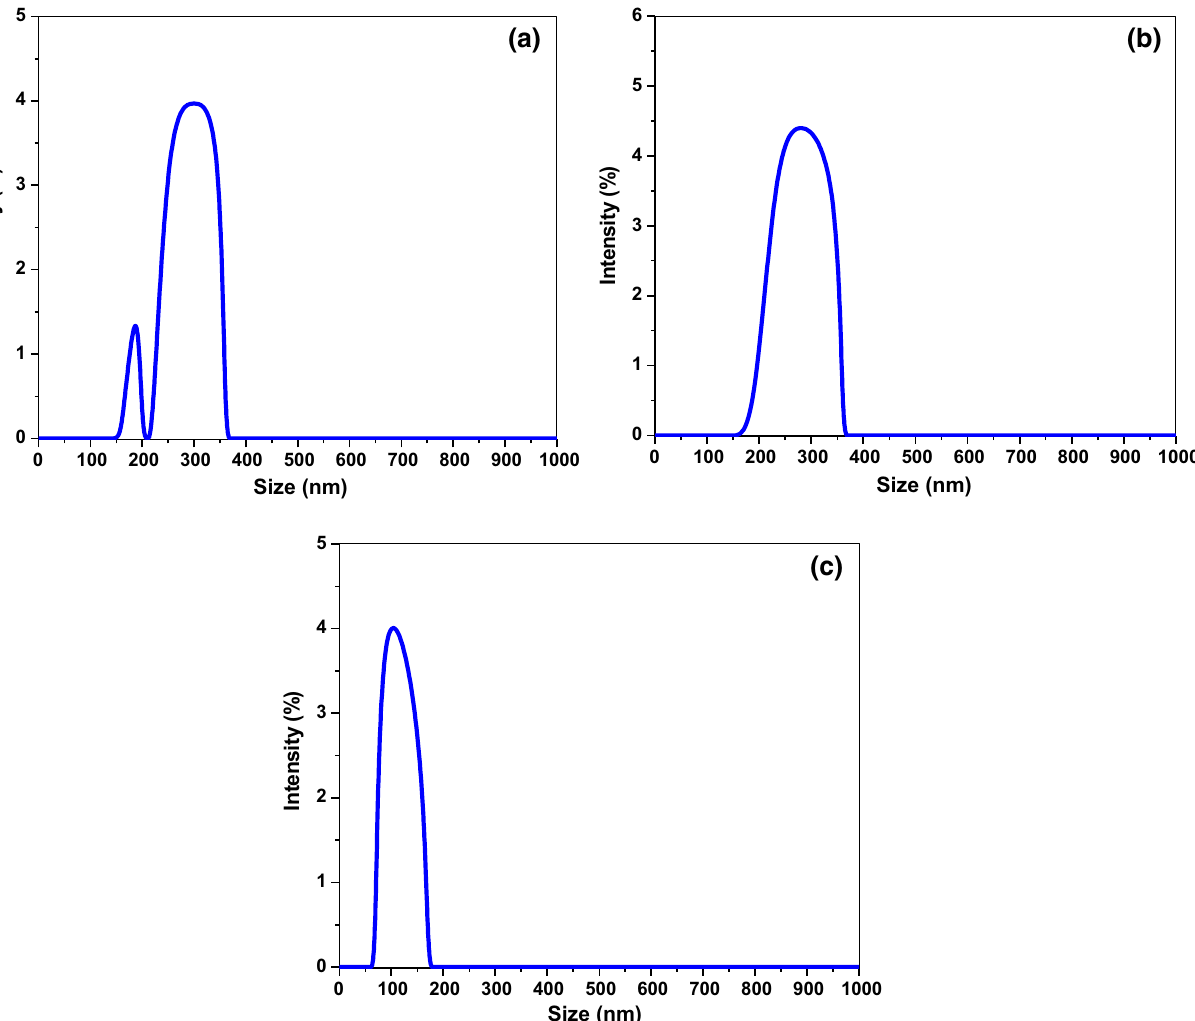
Fig. 7 Dynamic light scattering patterns of a Ag/ZnO nanoparticles b Cd/ZnO nanoparticles; c Pb/ZnO